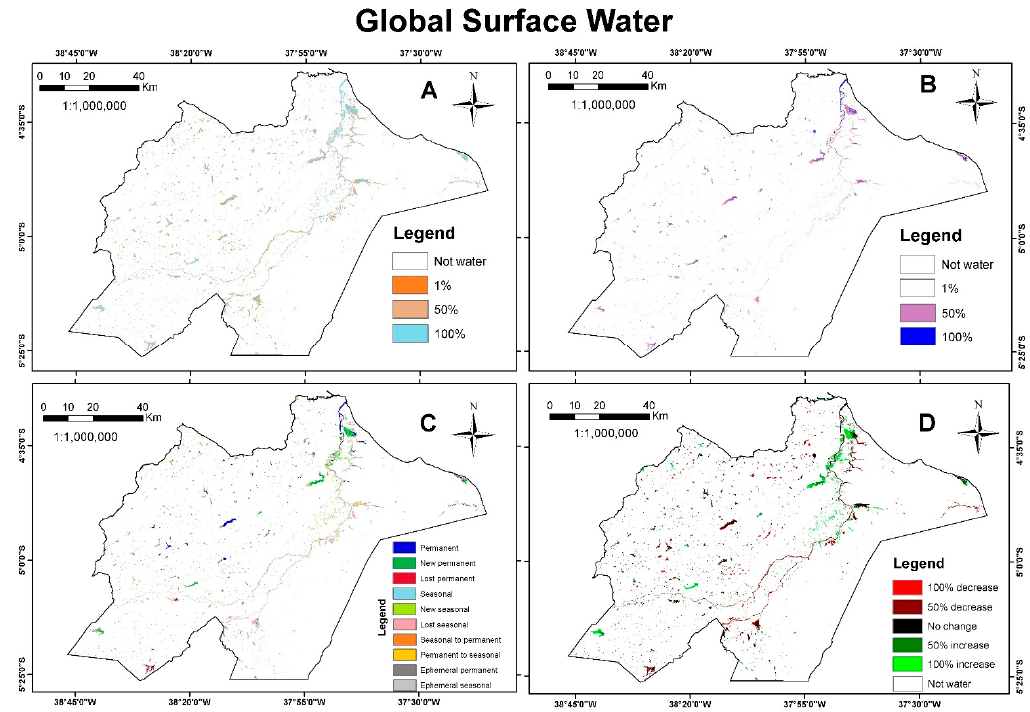
Figure 7. Surface water maps in the LJRSB showing water ( A ) recurrence, ( B ) occurrence, ( C ) tran- sition, and ( D ) change intensity.